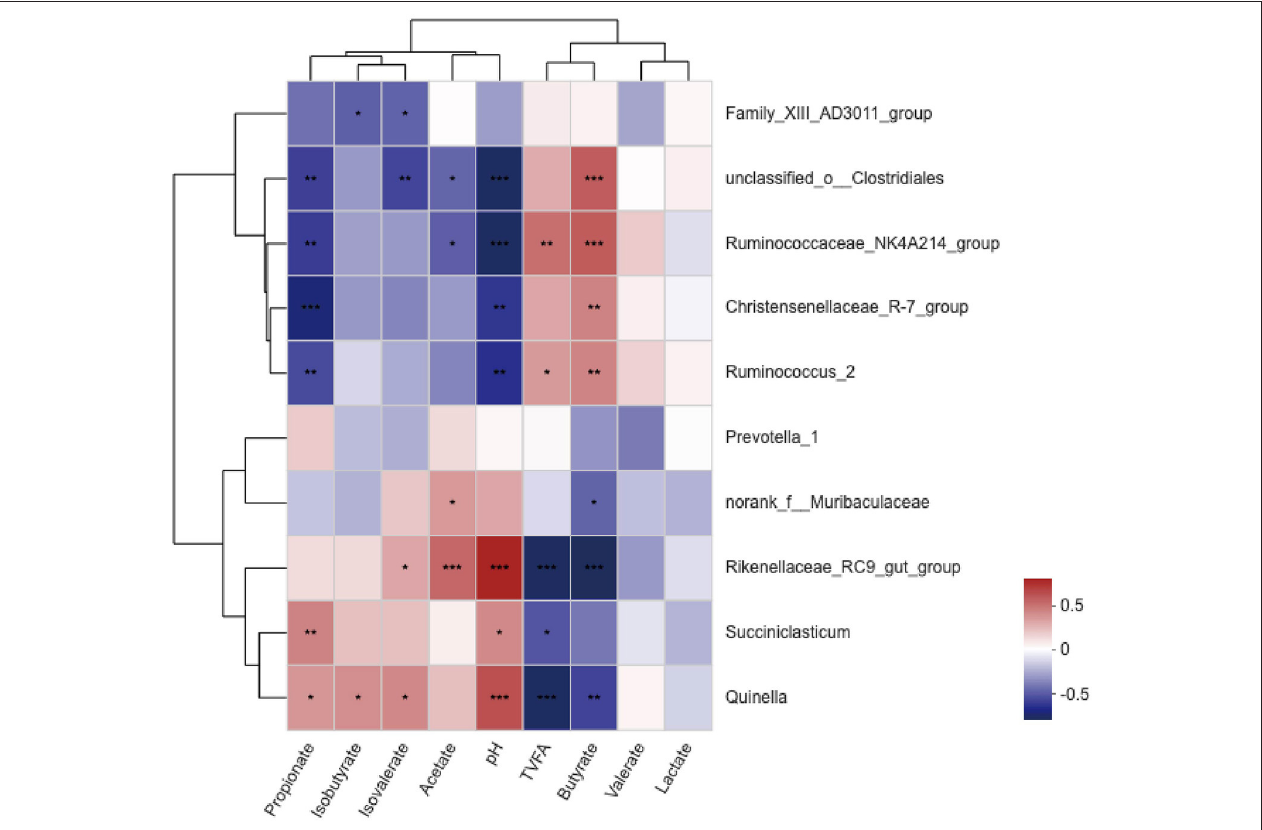
FIGURE 4 | Correlation analyses between the 10 most relatively abundant bacterial genera and ruminal fermentation parameters. The blue represents a negative correlation between the abundance of the species and the VFA concentration, the red color represents a positive correlation, and the white shows that the correlation was not significant (*0.01 < P ≤ 0.05, **0.001 < P ≤ 0.01, *** P ≤